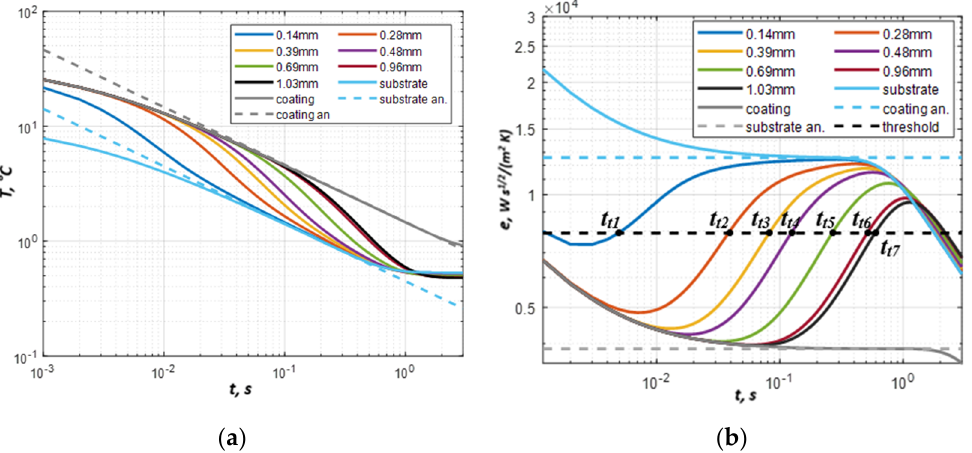
Figure 5. Determining thermal effusivity by modeling: temperature ( a ) and apparent effusivity ( b ) evolution.